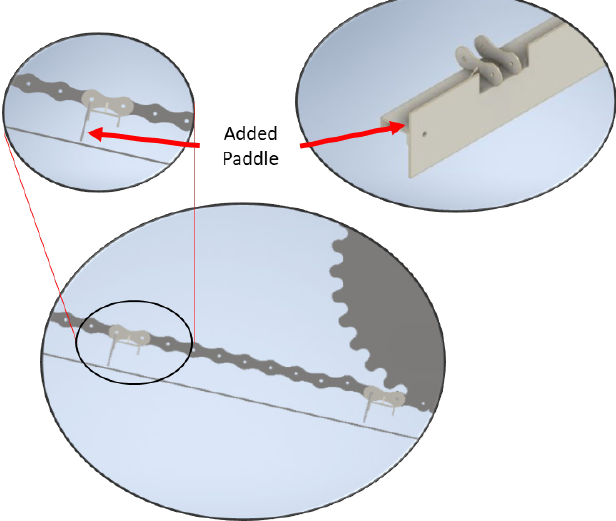
Figure 5. CAD model of the feeder house paddle concept.